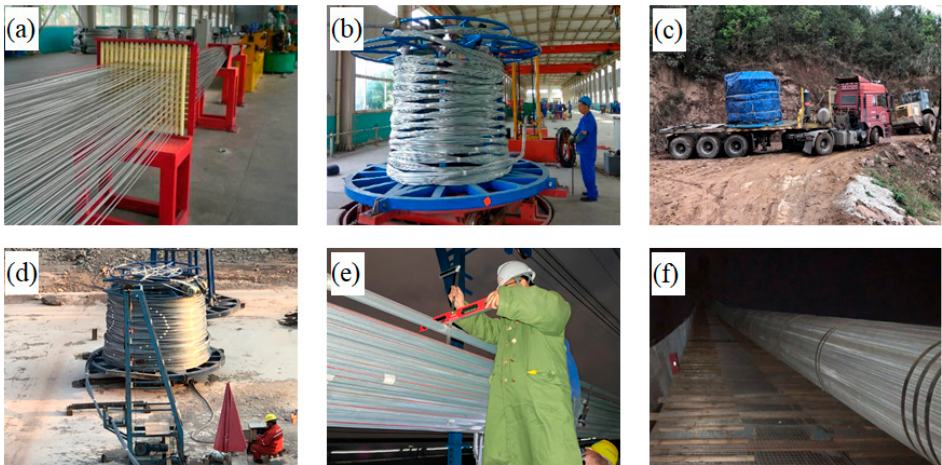
Figure 9. The main procedures of the PPWS method: ( a ) arrangement and binding of the steel wire, ( b ) the strand forming, ( c ) transportation of the strand, ( d ) the traction of the strand, ( e ) adjustment of the strand, ( f ) main cable forming.